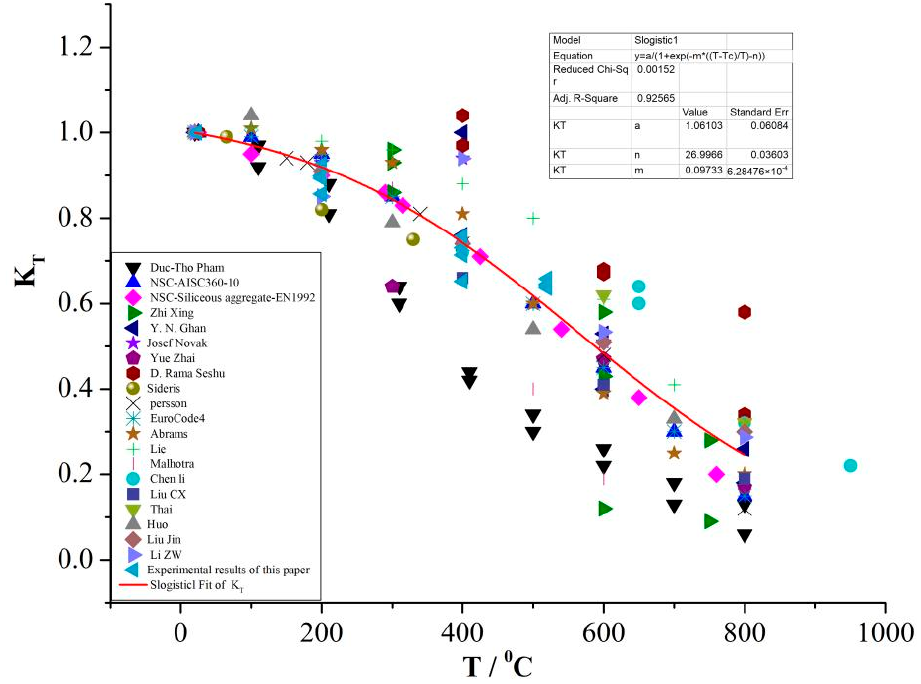
Figure 6. Temperature softening effect of compressive strength of air-drying concrete.